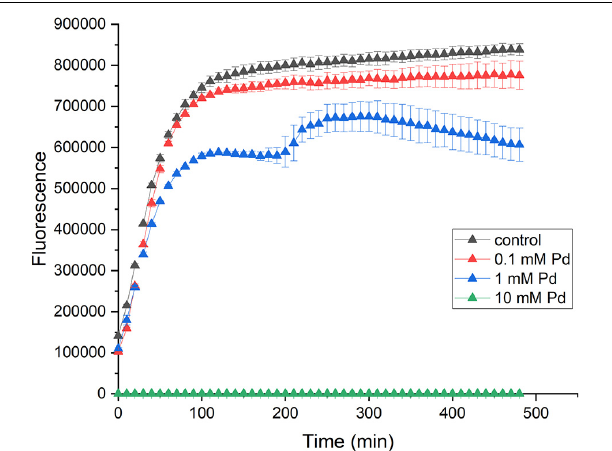
FIGURE 1 | Effect of Pd on the viability on E. coli . E. coli cells were incubated with 10 mM (green triangles), 1 mM (blue triangles), and 0.1 mM (red triangles) sodium tetrachloropalladate (II) or with water as a control (black triangles). The viability of cells was measured for 8 h. The error bars represent the standard deviation of the mean for three